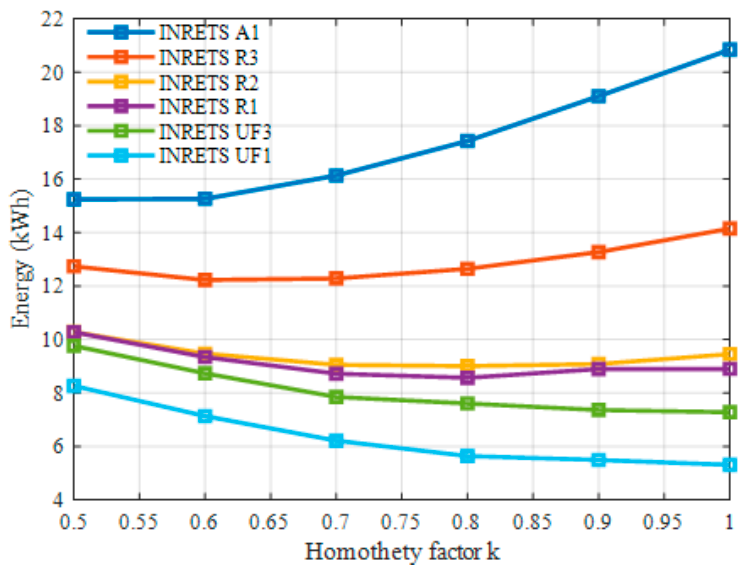
Figure 18. Total energy consumed for a driver dressed in an informal way, for (cid:1846) (cid:3032)(cid:3051)(cid:3047) = 36 °C , (cid:1844)(cid:1834) (cid:3032)(cid:3051)(cid:3047) = 50% (cid:1869)(cid:4662) (cid:3046)(cid:3048)(cid:3041) = 1000 W/m (cid:2870) , and different driving cycle.